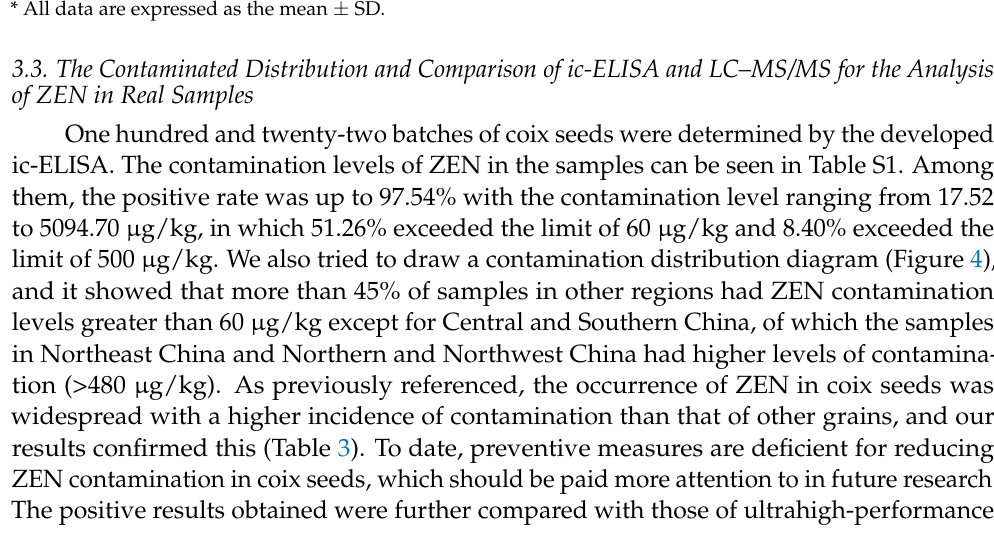
Table 2. Recoveries and coefficient variations for the accuracy in spiked coix seed ( n = 3). MRLs ( µ g/kg)